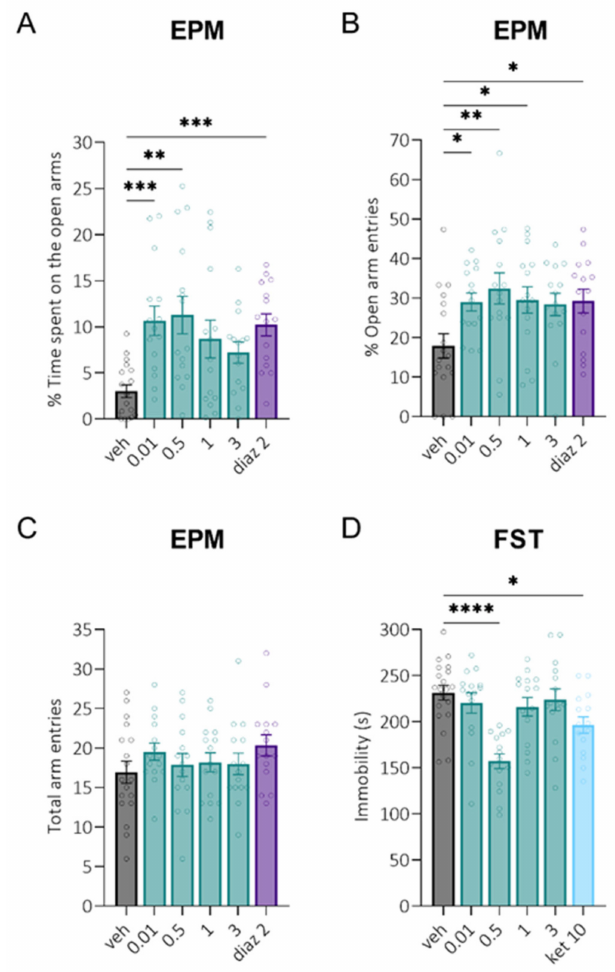
Figure 1. Anxiolytic-like and antidepressant-like efficacy of LCGA-17 after single i.n. administration in rats. Separate groups of animals ( n = 15–18) were treated with LCGA-17 at the dosages indicated of diazepam (diaz, 2 mg/kg, i.p.) or ketamine (ket, 10 mg/kg, i.p.), followed by behavioral testing 30 min later. ( A ) In the EPM, LCGA-17 increased the percent of time spent on the open arms, with significant effects at 0.5 mg/kg and 0.01 mg/kg (H (5, 87) = 22.6, p = 0.0004; K–W, Dunn’s test), similar to diazepam; ( B ) The anxiolytic-like response in the EPM was also reflected as an increased percent of open arms entries, which was significant at 0.5 mg/kg, 0.01, and 1 mg/kg (F (5, 87) = 2.9, p = 0.018; ANOVA, Dunnett’s test), similar to diazepam; ( C ) No effects of LCGA-17 or diazepam were observed on total arm entries in the EPM test (F (5, 87) = 0.89, p = 0.48; ANOVA); ( D ) In the FST, only in a dose of 0.5 mg/kg LCGA-17 reduced the duration of immobility to a greater extent than ketamine (F (5, 87) = 8.1, p < 0.0001; ANOVA, Dunnett’s test). * p < 0.05, ** p < 0.01, *** p < 0.001, and **** p < 0.0001 vs.